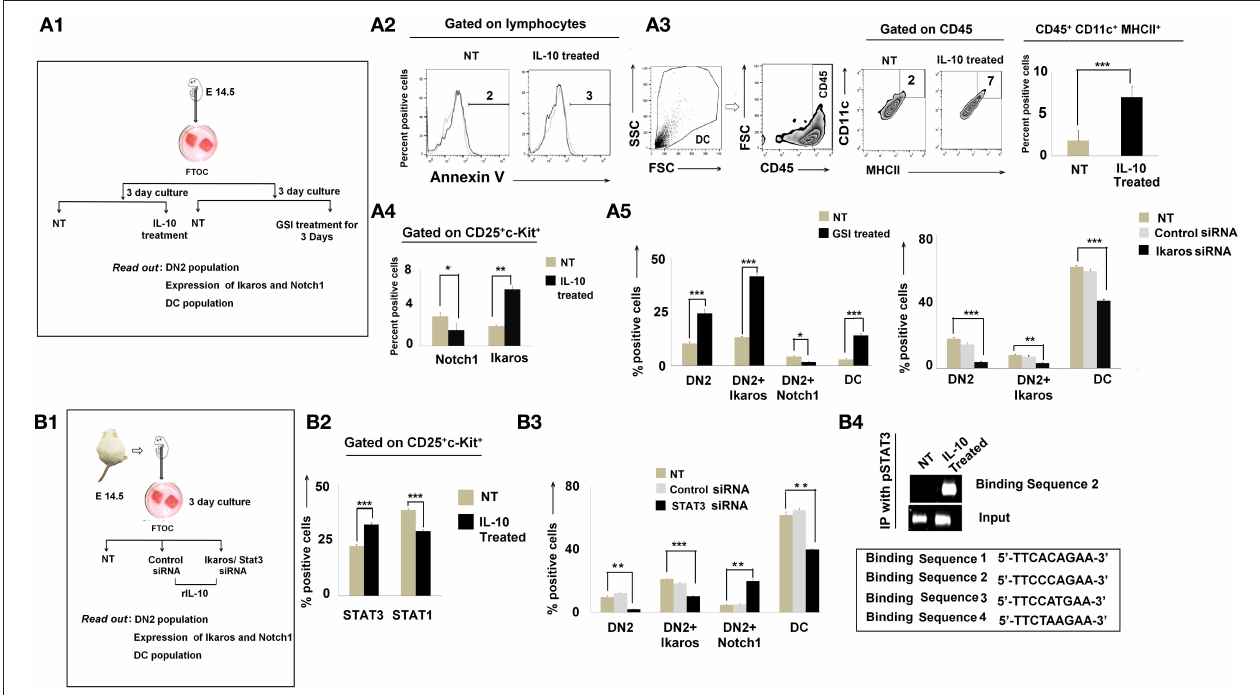
FIGURE 6 | IL-10 promotes DN2-to-dendritic cell lineage differentiation by Notch1/Ikaros signaling. (A1) Workflow diagram of the experimental design of fetal thymic organ culture (FTOC) using the fetuses of E14.5 pregnant mice. (A2) Total lymphocyte populations of FTOC were analyzed by Annexin V. Histograms of Annexin V + flow-cytometry results. Dotted line represents the isotype control. (A3) Total dendritic-cell population was checked in FTOC ± IL-10 treatment cohort. Representations of flow-cytometry results of CD11c + MHCII + cells, gated on CD45 + cells, and a bar diagram showing mean ± SE of percentage positive CD45 + CD11c + MHCII + cells from either untreated or IL-10-treated FTOC. n = 3; *** p < 0.001. (A4) Bar diagram to represent DN2 + Notch1 + and DN2 + Ikaros + cells from ± IL-10-treated FTOC, n = 3; * p < 0.05, ** p < 0.01 (A5) Bar diagrammatic representations of the mean ± SE of DN2 + , DN2 + Ikaros + , and DN2 + Notch1 + cells and DC population from untreated and GSI-treated cohorts in left panel along with mean ± SE of DN2 + , DN2 + Ikaros + cells, and CD45 + CD11c + MHCII + DC population from untreated, control siRNA-treated, and Ikaros siRNA-treated cohorts in right panel, n = 3; *** p < 0.001, ** p < 0.01, * p < 0.05. (B1) Workflow representing STAT3 and Ikaros silencing experiments with FTOC. (B2) Bar diagrammatic representation of mean ± SE of percentage of DN2 + STAT3 + and DN2 + STAT1 + cells in ± IL-10-treated cohort, n = 3; *** p < 0.001 (B3) Flow-cytometric analysis was performed; bar diagram showing mean ± SE of percentage of DN2 + , DN2 + Ikaros + , DN2 + Notch1 + , and CD45 + CD11c + MHCII + DC population from untreated, control siRNA-treated and STAT3 siRNA-treated cohorts, n = 3; *** p < 0.001, ** p < 0.01. (B4) ChIP assay for pSTAT3 recruitment to the putative binding site downstream of the Notch1 promoter. Gene expression patterns of different binding sites show that upon IL-10 treatment, a specific binding site (binding sequence 2) of the downstream region of Notch1 promoter sequenced 5 ′ TTCCCAGAA 3 ′ becomes bound by pSTAT3 and Notch1 becomes